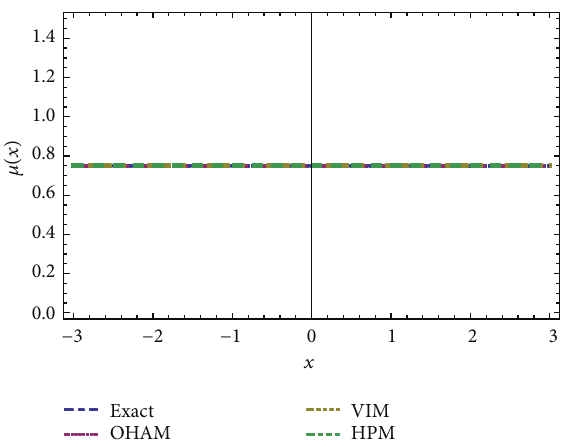
Figure 21: 2D, comparison of ordered solutions for 𝜇(𝑥,𝑡) at 𝑡 = 0.1 .